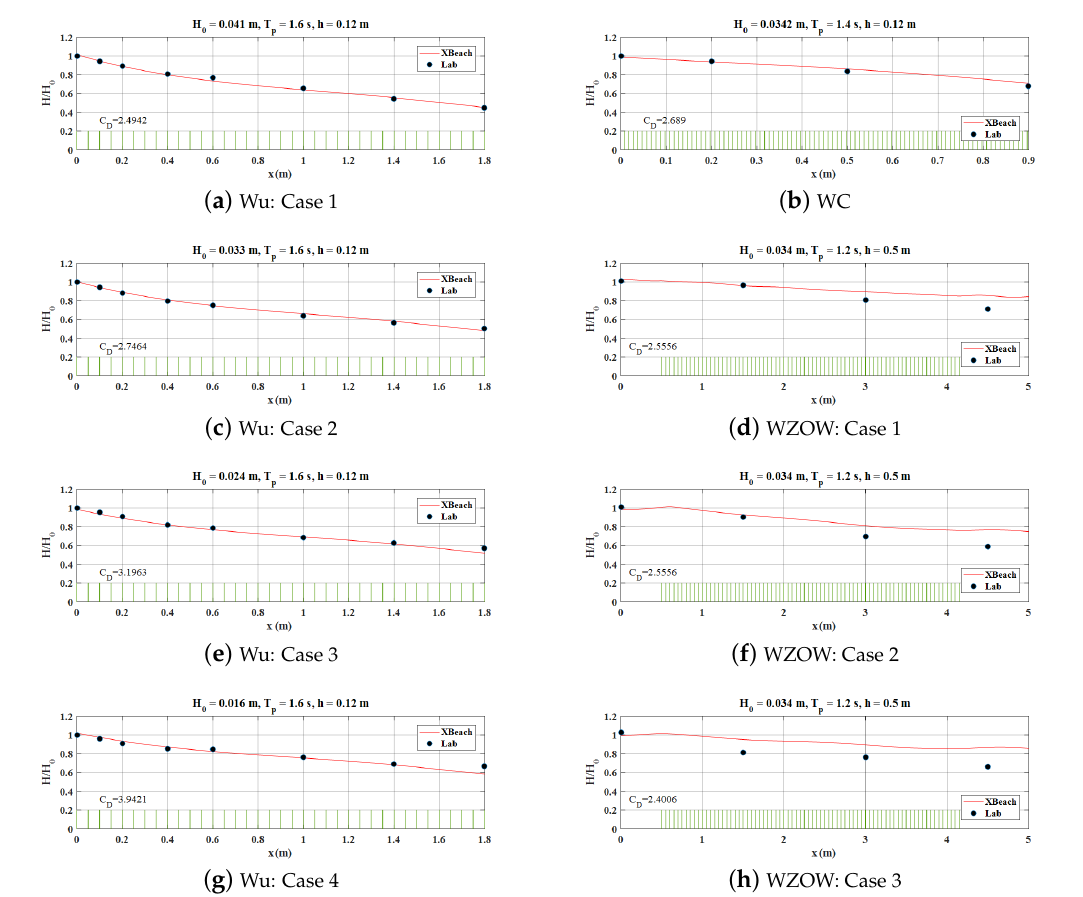
Figure 11. Normalized wave height across the model vegetation for all 8 cases listed in Table 2. ( a ) Case 1 of Wu [36]. ( b ) Wu and Cox [37]. ( c ) Case 2 of Wu [36]. ( d ) Case 1 of Wu et al. [12]. ( e ) Case 3 of Wu [36]. ( f ) Case 2 of Wu et al. [12]. ( g ) Case 4 of Wu [36]. ( h ) Case 3 of Wu et al. [12]. Symbol: measurements. Line: numerical results with the of C D calculated explicitly by (6). Vertical bars at the bottom are plotted to indicate the location of the vegetation patch and do not reflect the real stem heights. See Table 2 for the detailed experimental